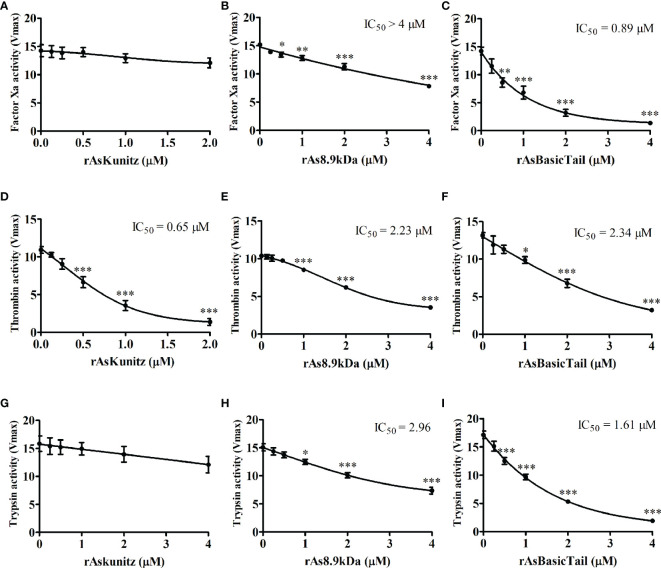
Effect of the recombinant proteins on the activity of factor Xa (A–C), thrombin (D–F), and trypsin (G–I). Data is shown as mean ± standard error (SE). Statistical analysis: ANOVA–Dunnett, *p < 0.05, **p < 0.01, and ***p < 0.001 indicate difference from the sample without recombinants (0 µM).